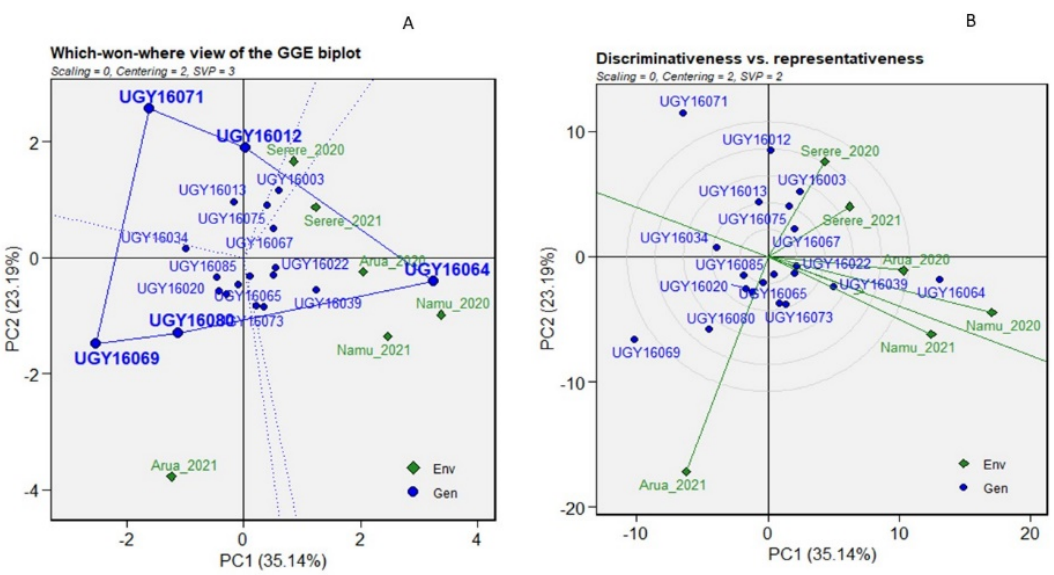
Figure 9. GGE scatterplots based on symmetrical scaling for ( A ) the “which-won-where” pattern ( A ) and the discriminating power and ( B ) representativeness of test environments for dry matter content involving 20 yam genotypes evaluated in six environments.